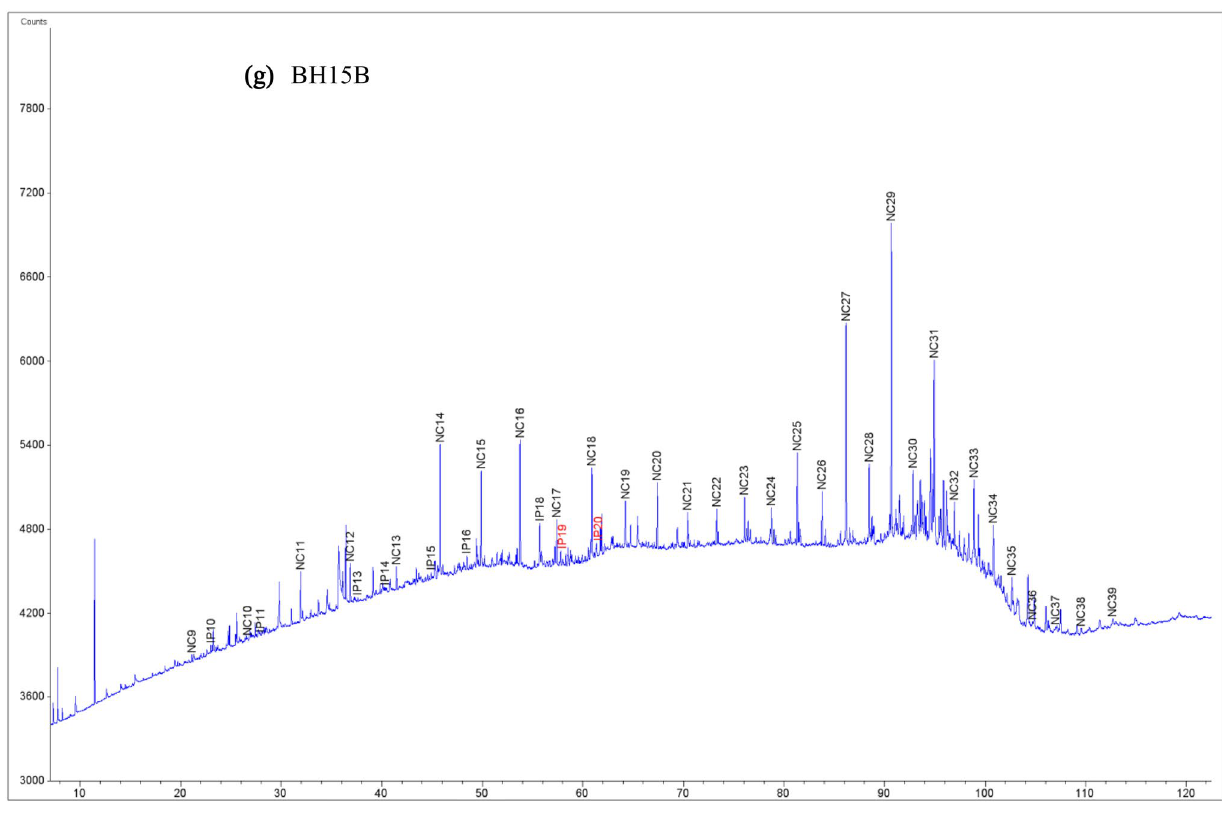
Fig. 14 Plot of Pr/ n -C 17 versus Ph/ n -C 18 of coal and shale sam- ples of Maiganga, Gombe for- mation. The coals fall within the terrestrial sources in oxic depo- sitional settings, shales plotted within the mixed sources. after Peters et al.